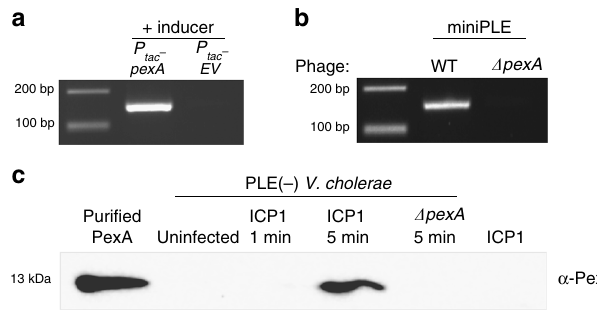
Fig. 3 ICP1-encoded PexA is necessary and suf fi cient for PLE cirularization. a miniPLE circularizes in the absence of ICP1 infection upon ectopic expression of PexA. b miniPLE does not circularize during ICP1 infection when pexA is knocked out. c Western blot for PexA during ICP1 infection. PLE − V. cholerae cultures were probed for PexA at the listed times after infection with ICP1 or ICP1 Δ pexA . To determine if PexA is packaged in the phage particle, 5 times the PFU of phage as was used for infection was probed for the presence of PexA. Puri fi ed PexA (20 ng) was used as a positive control. Uncropped gels are presented in Supplementary Fig. encoded excisionase (PexA). PexA is a small protein unique to ICP1 isolates that has no sequence similarity to known proteins.